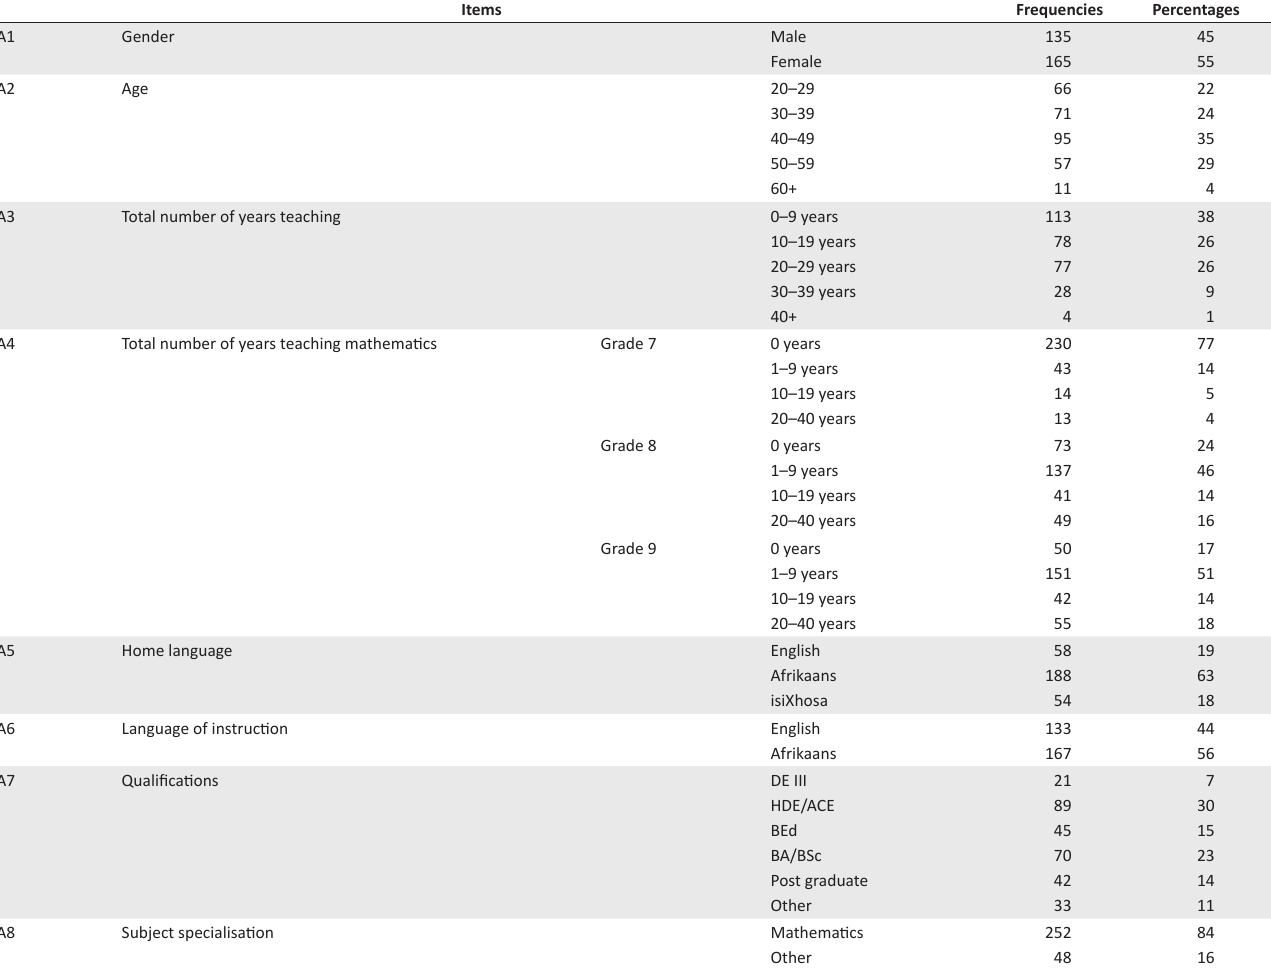
TABLE 6: Descriptive statistics for Parts A and